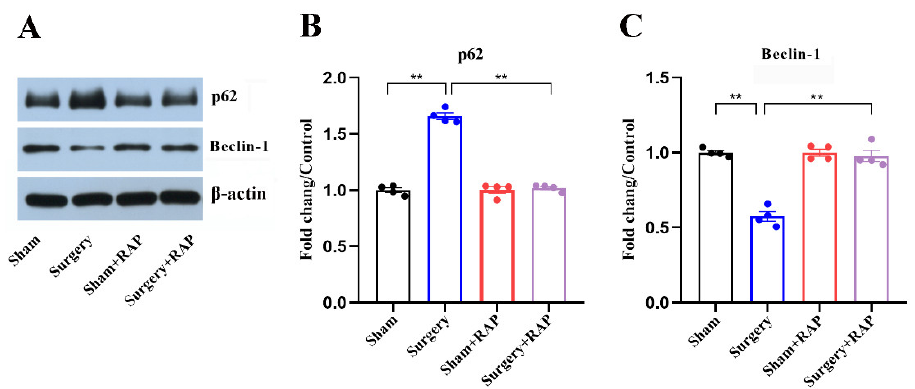
Figure 5. Rapamycin rescued the inhibited autophagy in hippocampal synaptosomes of aged rats. ( A ) Representative immunoblots illustrating the effects of rapamycin on surgery-induced changes in hippocampal autophagy-related protein levels. ( B ) Rapamycin reversed the surgical stress-induced increase in p62 levels and decrease in Beclin-1 levels ( C ) in hippocampal synaptosomes. Values represent the mean ± SEM, n = 4 per group. ** p < 0.01 surgery vs. sham group or surgery+rapamycin vs. surgery group. RAP: rapamycin.